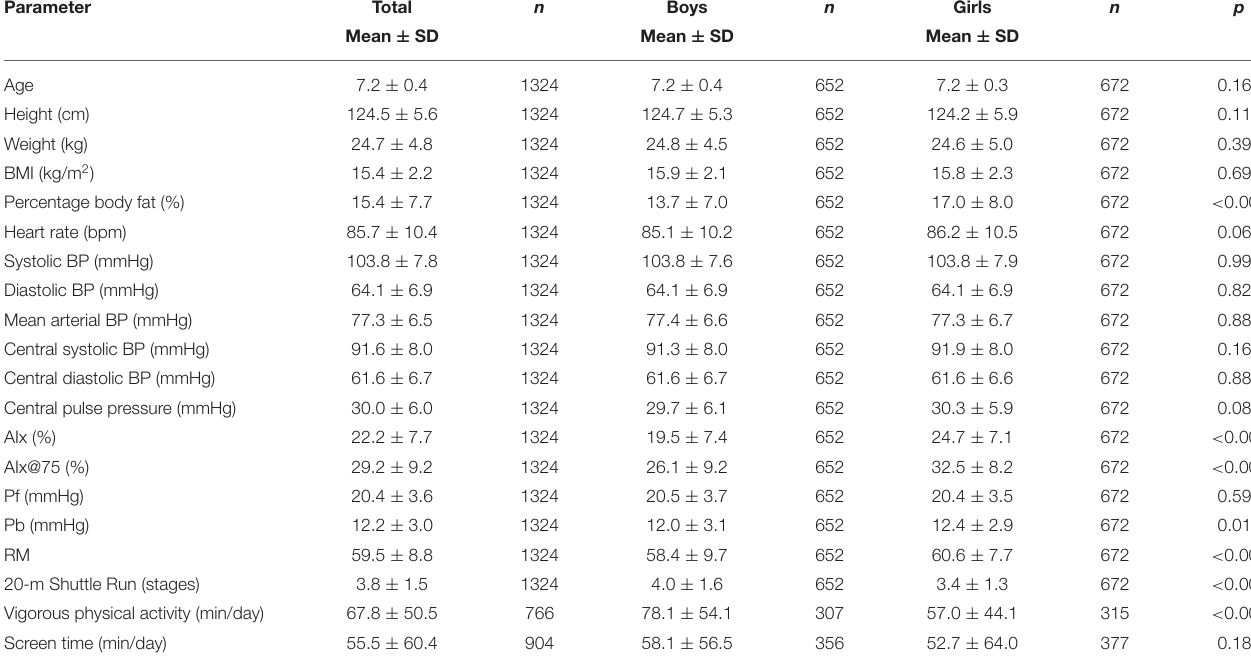
TABLE 1 | Population characteristics of the study.